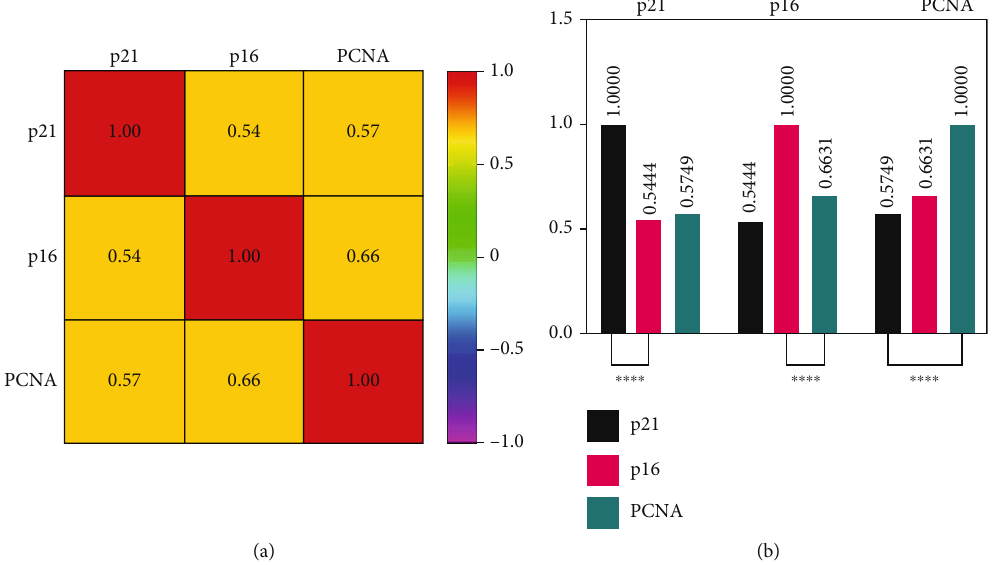
Figure 4: Correlation analysis in FFPE samples. (a) Heatmap of Spearman ’ s correlation test between p21, p16, and PCNA in FFPE samples. r coe ffi cient is placed inside the cells with a variation from 1 (strongest positive correlation) to -1 (strongest negative correlation). (b) Correlation between p16, p21, and PCNA in FFPE samples. Each gene section shows the positive ( r = 1 ) or negative ( r = − 1 ) correlation coe ffi cient in the bar notation of the analyzed target. p value: ∗∗∗∗ <